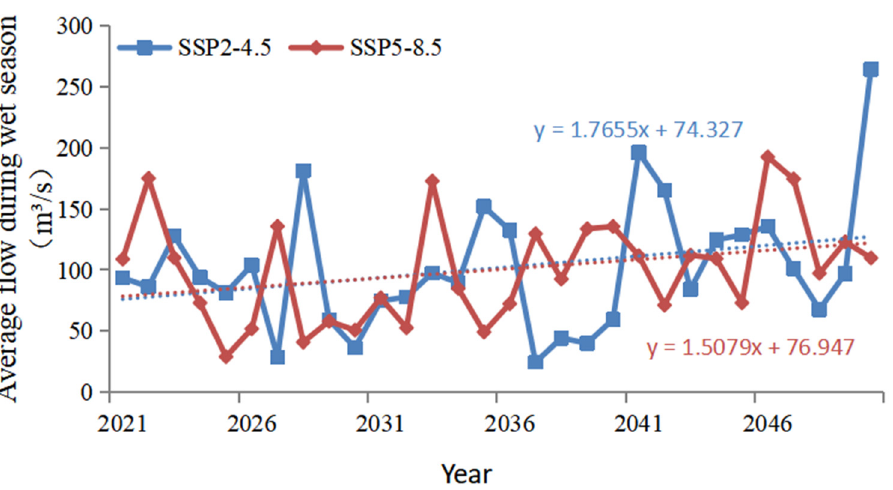
Figure 5. Changes in annual runoff during the wet season under two climate scenarios from 2021 to 2050.